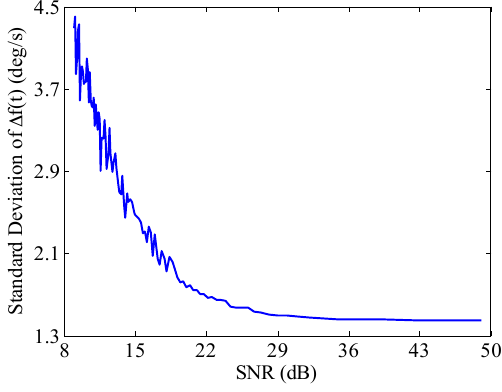
Figure 8. Impact of the SNR on the accuracy of the BCZT.